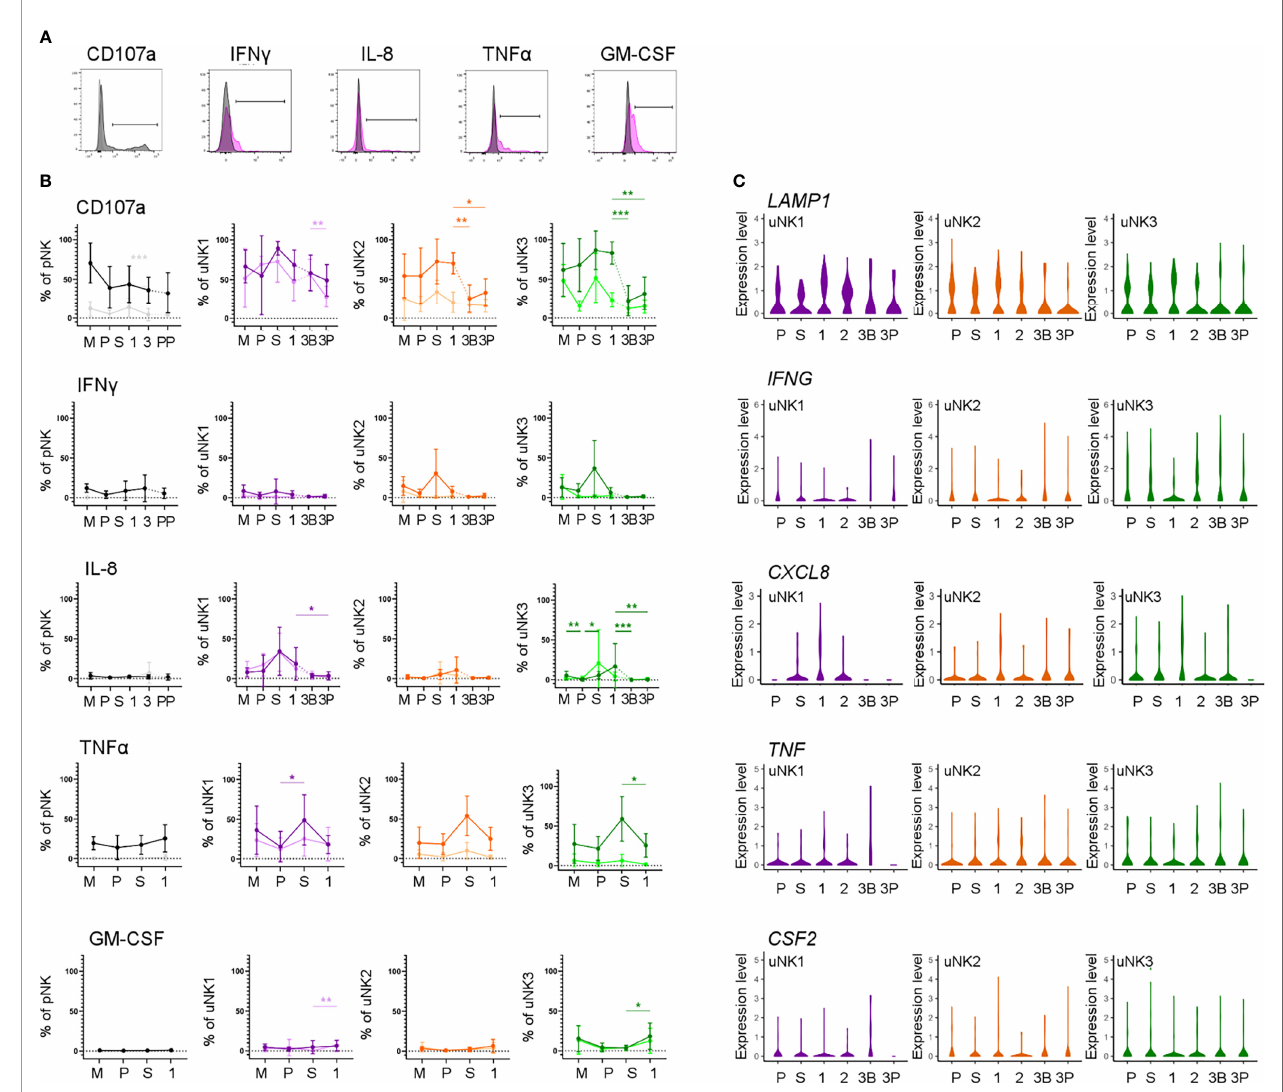
FIGURE 4 | uNK are most active at the time of implantation. (A) Uterine and peripheral NK cells taken at different stages of the reproductive cycle were cultured with or without PMA and ionomycin stimulation and assessed for degranulation (CD107a) and production of IFN g , IL-8, TNF a and GM-CSF. Representative staining of CD107a on total pNK is shown in black, alongside FMO controls in light grey. Representative staining from secretory phase uNK1 is shown for the cytokines in pink, alongside internal negative controls in grey. The positive gates were set by reference to FMO controls. (B) Graphs showing frequencies of CD107a, IFN g , IL-8, TNF a and GM-CSF on pNK and uNK subsets. Unstimulated cells are represented by lighter lines and stimulated cells by darker lines. Means and standard deviations are shown for n = 5 (menstrual), n = 6 (proliferative), n = 10 (secretory) n= 10 ( fi rst trimester), n= 16 (third trimester decidua basalis), n = 16 (third trimester decidua parietalis). Statistical testing was done using Kruskal Wallis with a post-hoc Dunn test *p < 0.05, **p < 0.01, ***p < 0.001, and ****p < 0.0001. (C) Violin plots showing corresponding mRNA expression in uNK subsets over the reproductive cycle as determined by scRNAseq. M, menstrual phase; P, proliferative phase; S, secretory phase; 1, fi rst trimester; 2, second trimester; 3, third trimester; 3B, third trimester decidua basalis; 3P, third trimester decidua